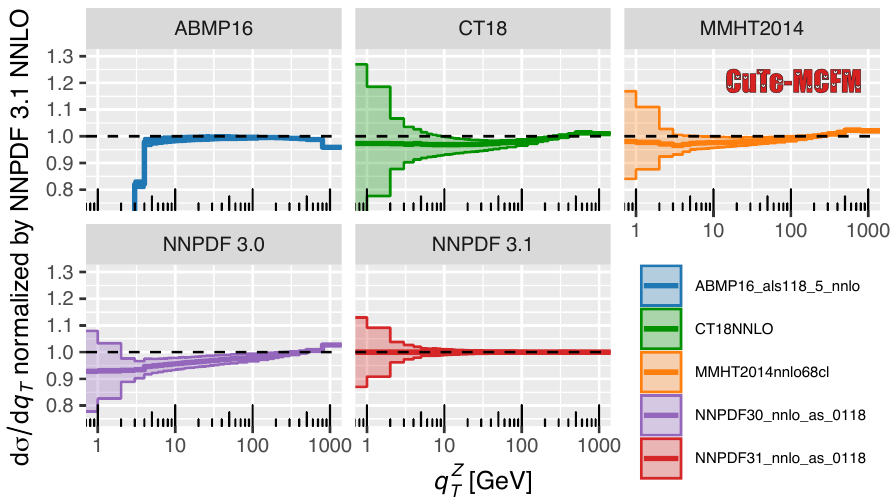
Figure 10. Z -boson transverse-momentum distribution including PDF uncertainties for various PDF sets normalized to the prediction with the NNPDF3.1 NNLO central value. See figure